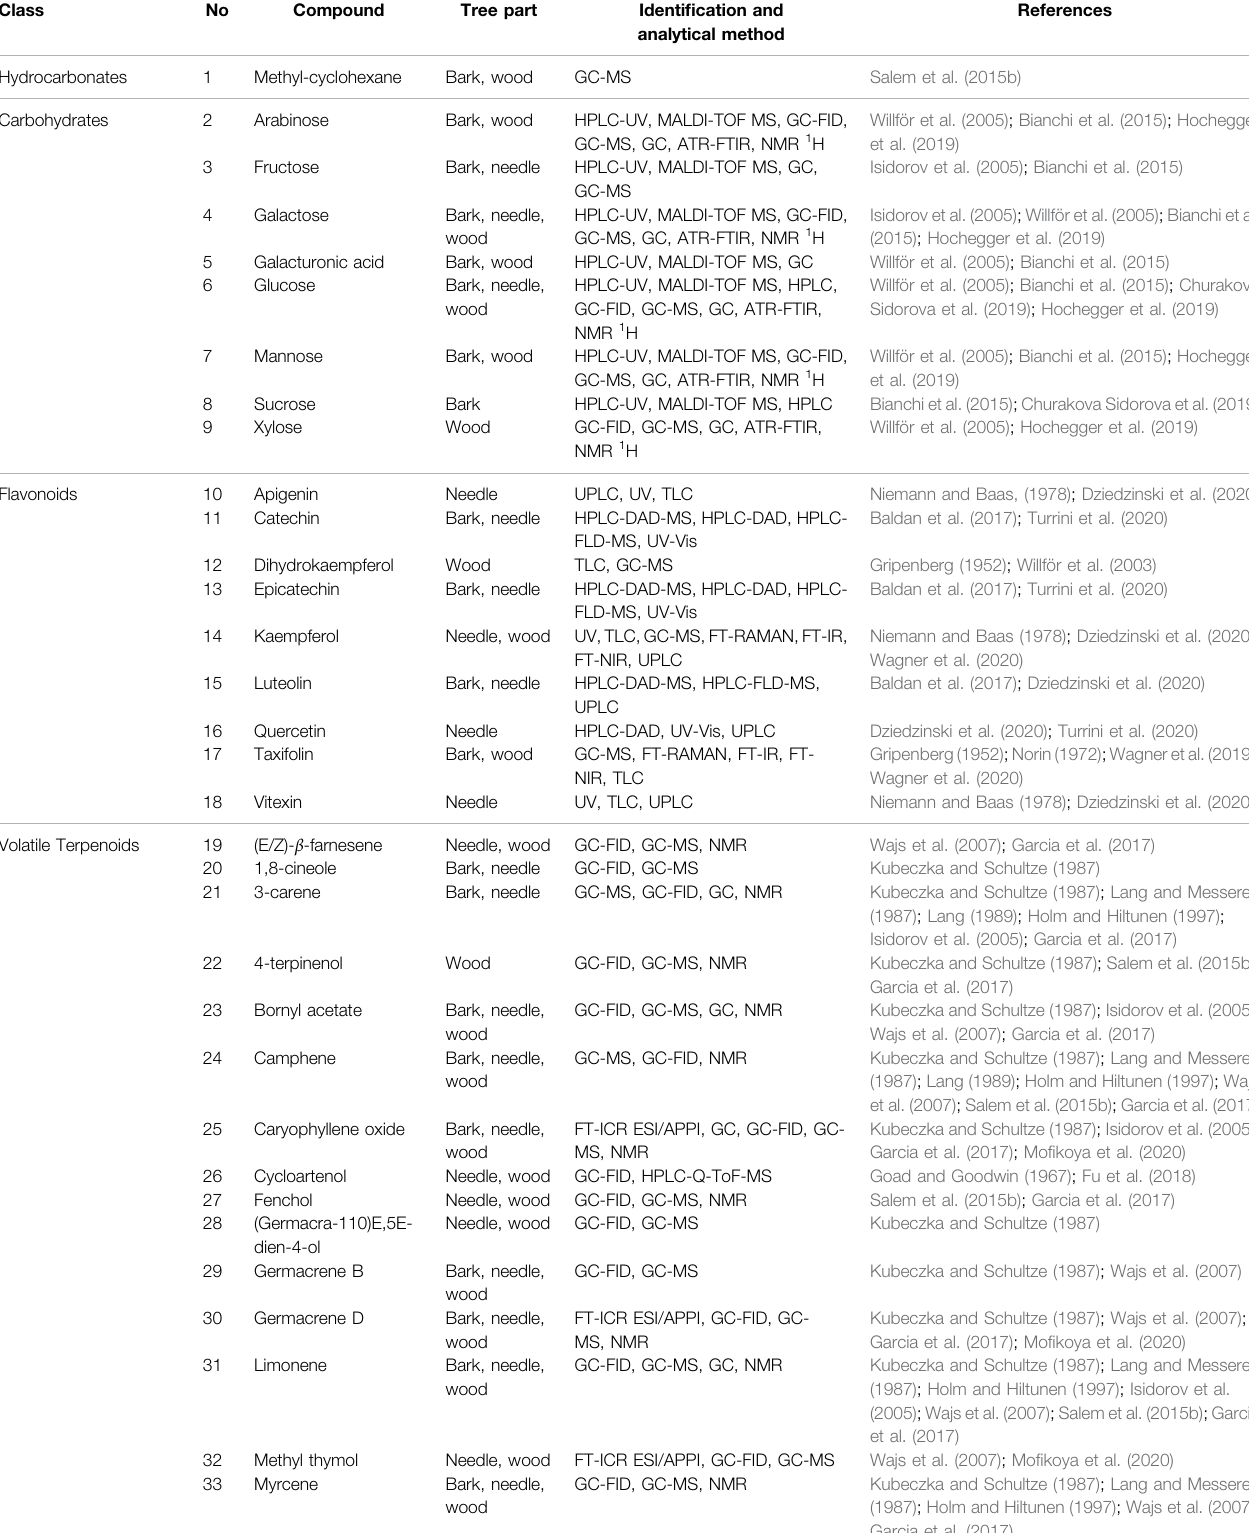
TABLE 2 | Chemical data of the 118 most important identi fi ed compounds from Larix decidua Mill. [Pinaceae], organized by chemical class, tree part, identi fi cation and analytical method. Abbreviations described in Section 3.2 .